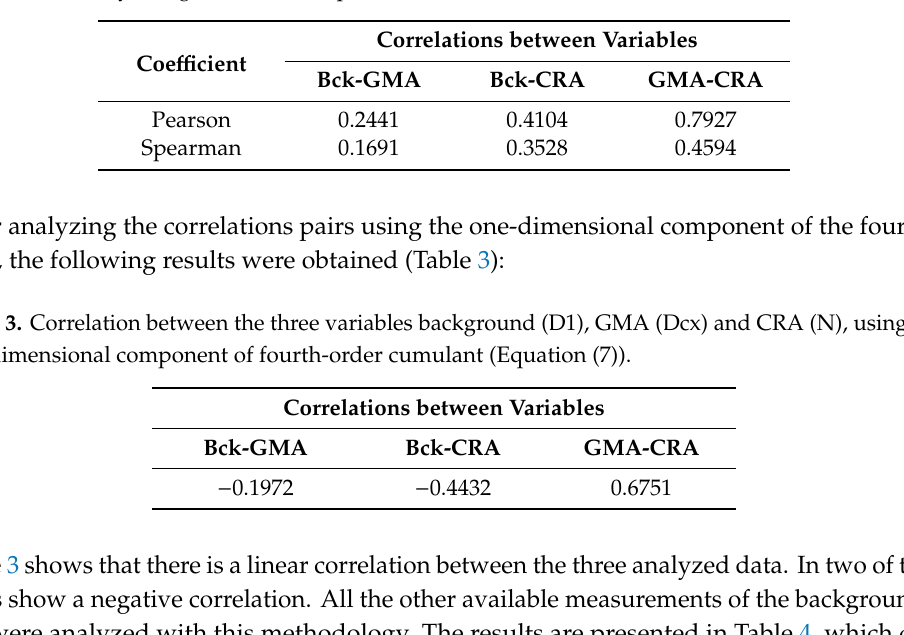
Table 2. Correlation between the three variables background (D1), GMA (Dcx) and CRA (N). A comparative study using Pearson and Spearman Coe ffi cients.